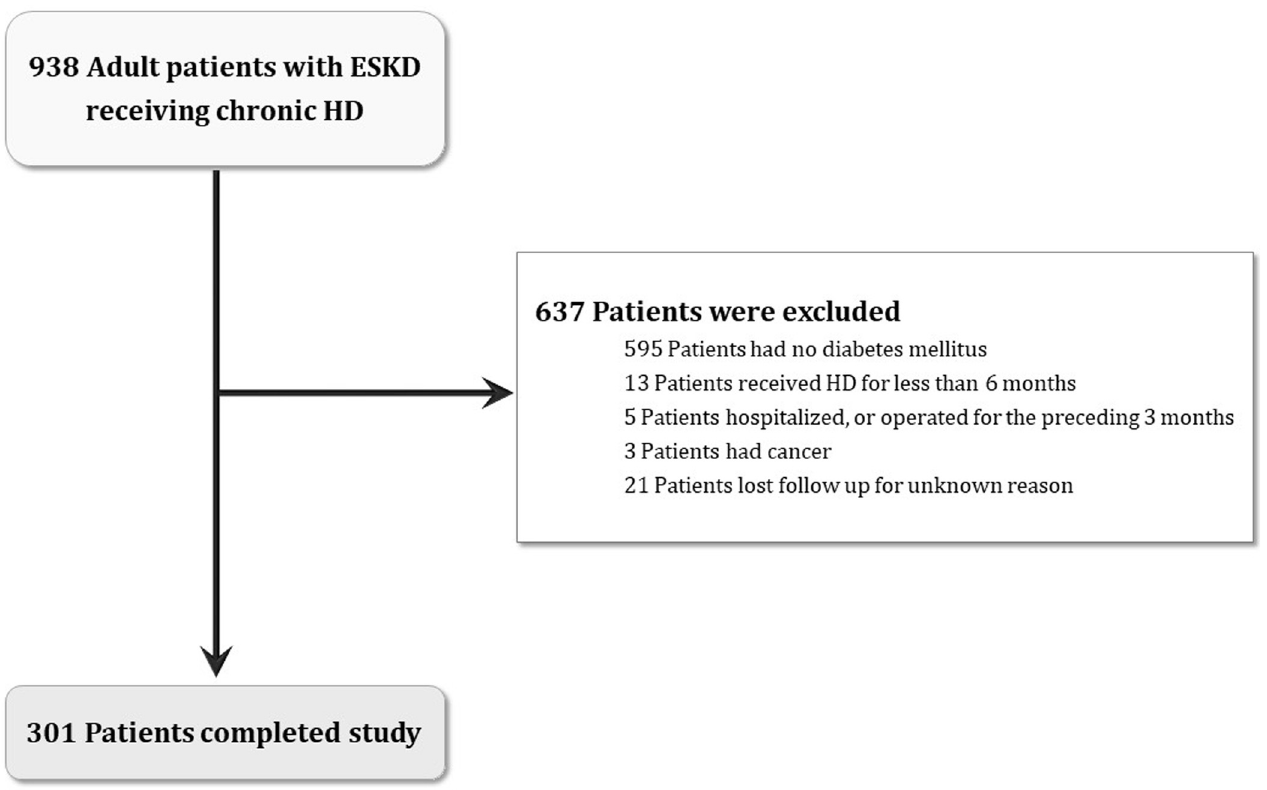
Fig 2. Flow chart. Diagram shows the enrolment and status of patients. ESKD end-stage kidney disease, HD hemodialysis.